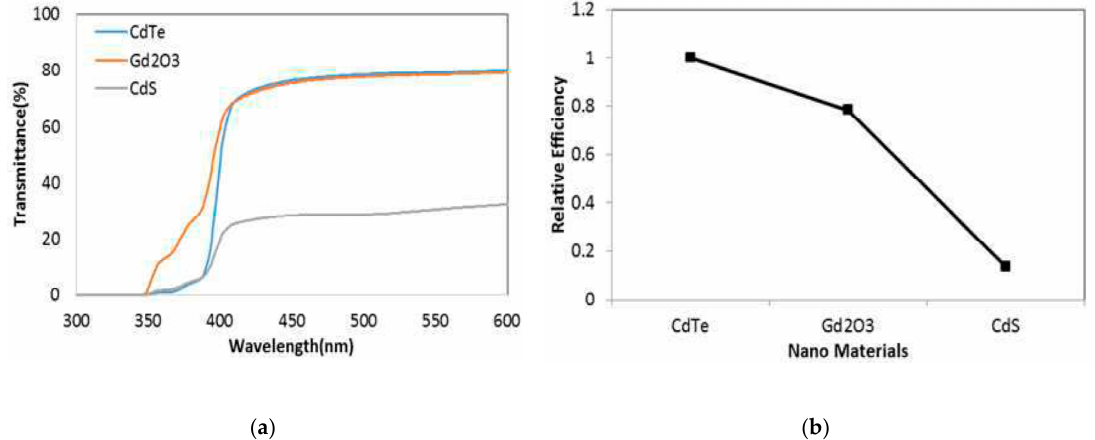
Figure 28. Compared plastic scintillators with nanomaterial: ( a ) transmittance with wavelength and ( b ) relative efficiency of scintillators with nanomaterial [95].